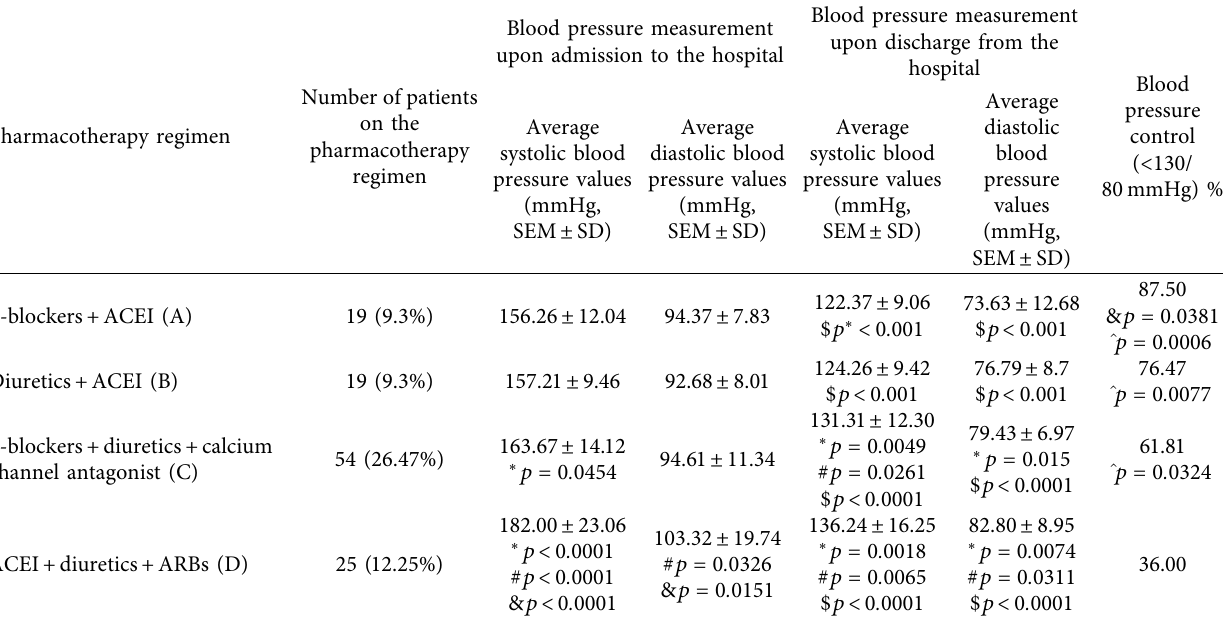
Table 5: Evaluation of efficacy of hypertension treatment in hospital environment according to the most common pharmacotherapy